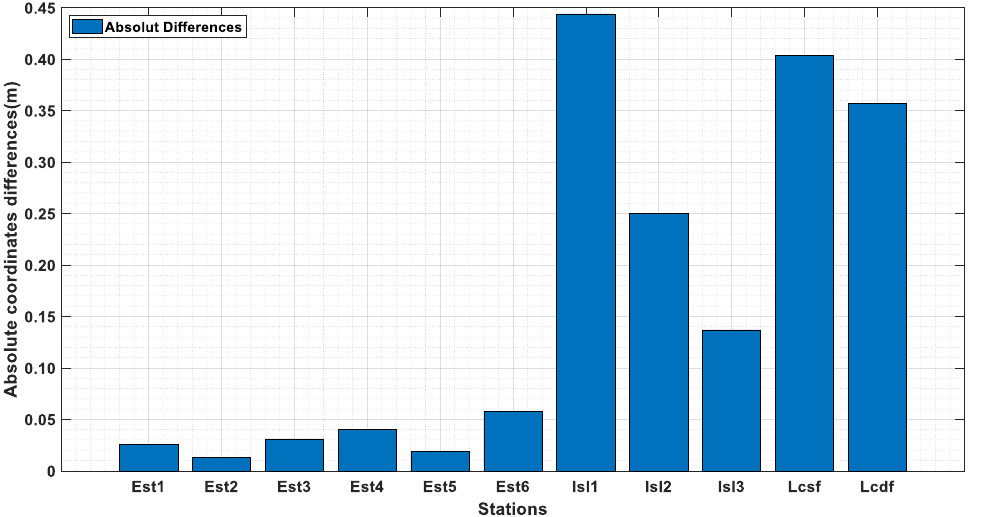
Figure 13. Absolute coordinates differences between the static relative and the PPP methods. Table 9. Absolute difference between the PPP and the static relative methods in m.